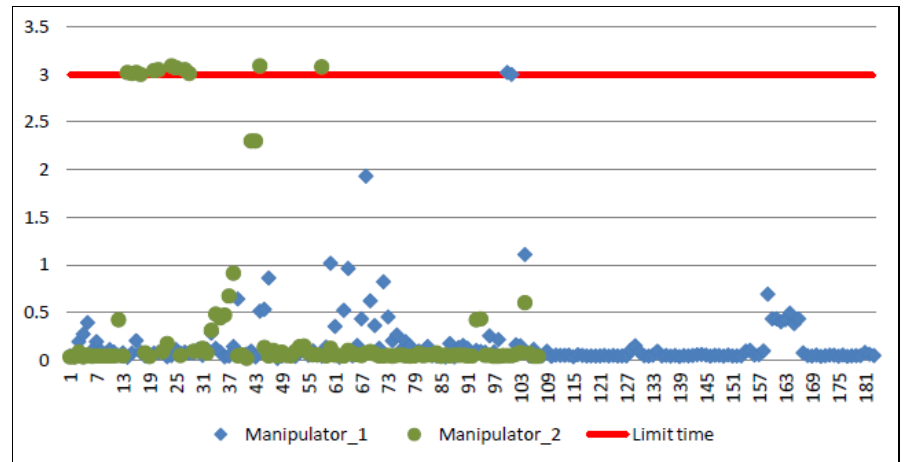
Figure 11. Times of trajectory planning with “RRT connect” to weld workpiece 2 in a horizontal position with two robots (vertical: planning time in seconds¸ horizontal: number of motion plan executions).